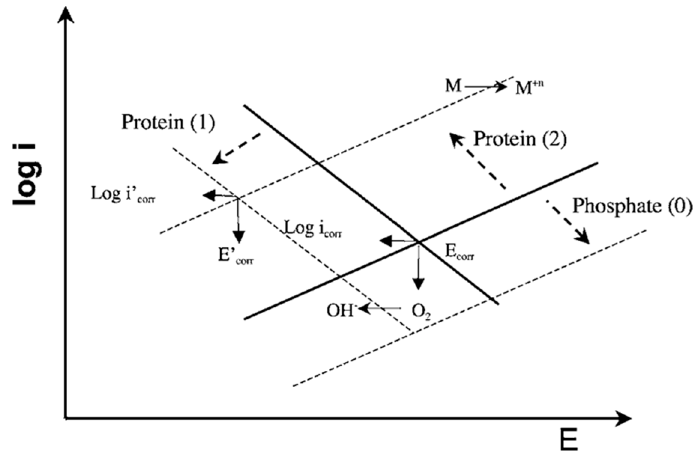
Figure 8. Mixed potential theory for interpretation of the effect of albumin and phosphates on the electrochemical behavior of a CoCrMo alloy. Phosphates inhibit anodic reaction (arrow 0). The albumin inhibits cathodic reaction (arrow 1) and accelerates the metal anodic oxidation by binding to metal ions (arrow 2) [29].